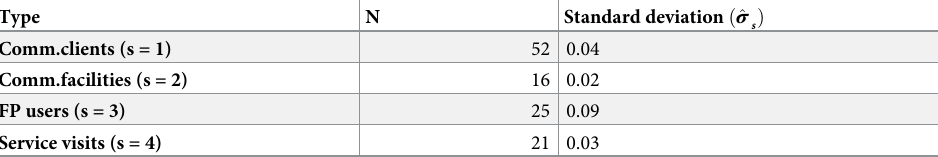
Table 2. Estimates of the standard deviation of differences between changes in EMU observations and changes in survey-informed estimates of mCPR ( Δ EMU– Δ P) across EMU data